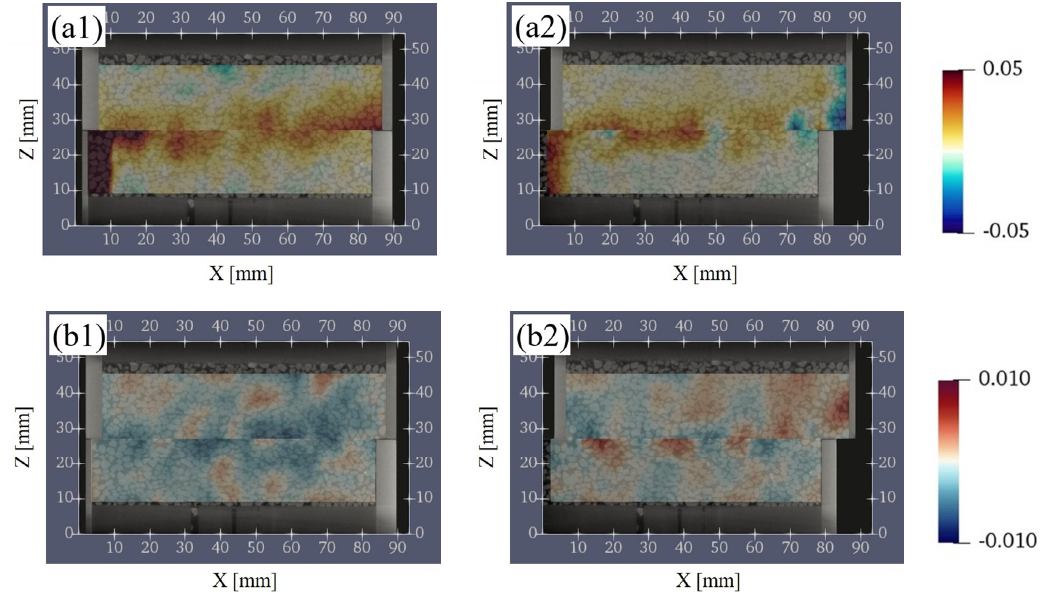
Figure 12. Change in the porosity and the ratio of contact surface between particles on the vertical plane (XZ plane). ( a1 , a2 ) show the change in the porosity. ( b1 , b2 ) show the change in the ratio of contact surface between particles. The left columns represent the change between S1 (D h = 0.3 mm) and S2 (D h = 3 mm), and the right columns represent the change between S3 (D h = 5 mm) and S4 (D h = 8 mm). D h , horizontal displacement.